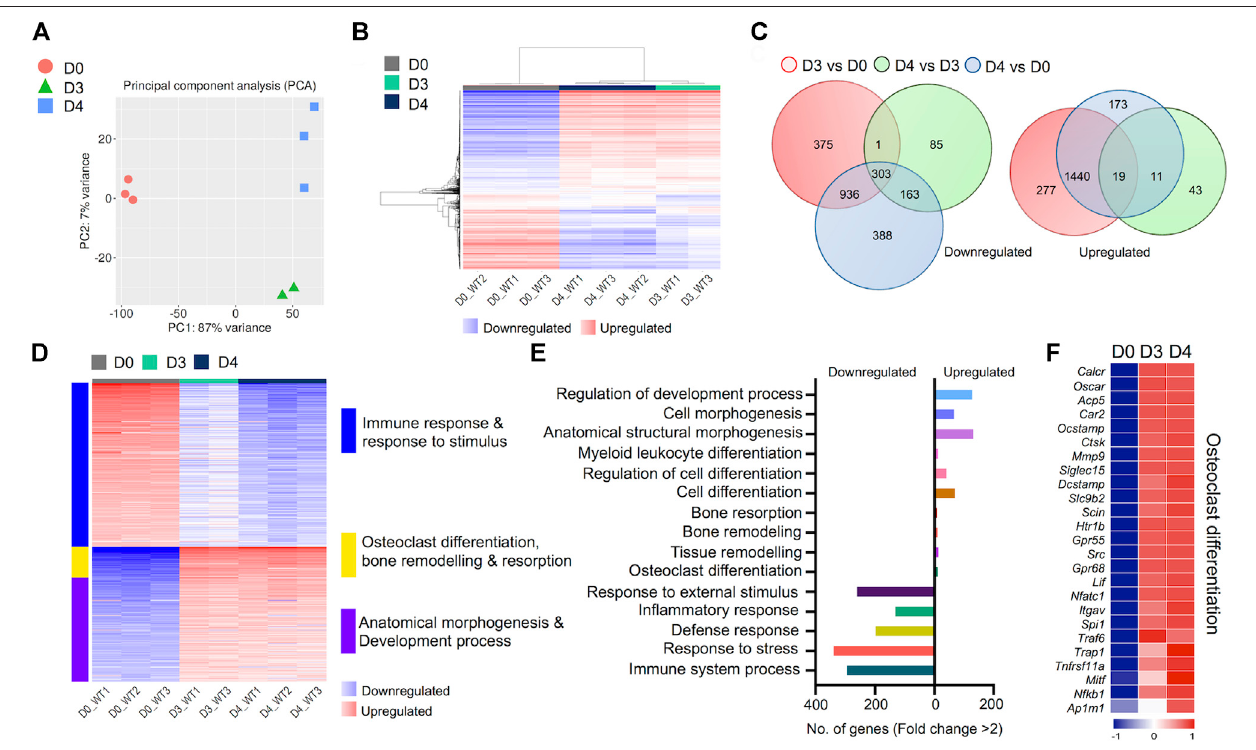
FIGURE 2 | Transcriptomic pro fi ling of osteoclast differentiation. The transcriptomes of bone marrow derived macrophages (BMDM; D0) were compared with osteoclast precursors (D3)and fully differentiated osteoclasts (D4)byperforming differential geneexpression analyses. (A) PCA plot shows variability ingene expression among biological replicates between D0, D3 and D4. (B) Heatmap shows hierarchical clustering of gene expression in cells from D0, D3 and D4. (C) Venn diagram depicts the total numbers of overlapping differentially regulated (downregulated and upregulated) genes between D0, D3 and D4. (D) Heatmap shows gene enrichment and associated pathwaysin D0, D3 and D4. (E) Bar plotshows the numbers ofgenes correspondingto signi fi cantlyup/downregulated functionalpathways fromgeneontologyenrichmentanalyses. (F) Heatmapshowsthegeneexpression(Z-scores)ofosteoclast-relatedgenepanelforcon fi rmationofosteoclastgeneration.